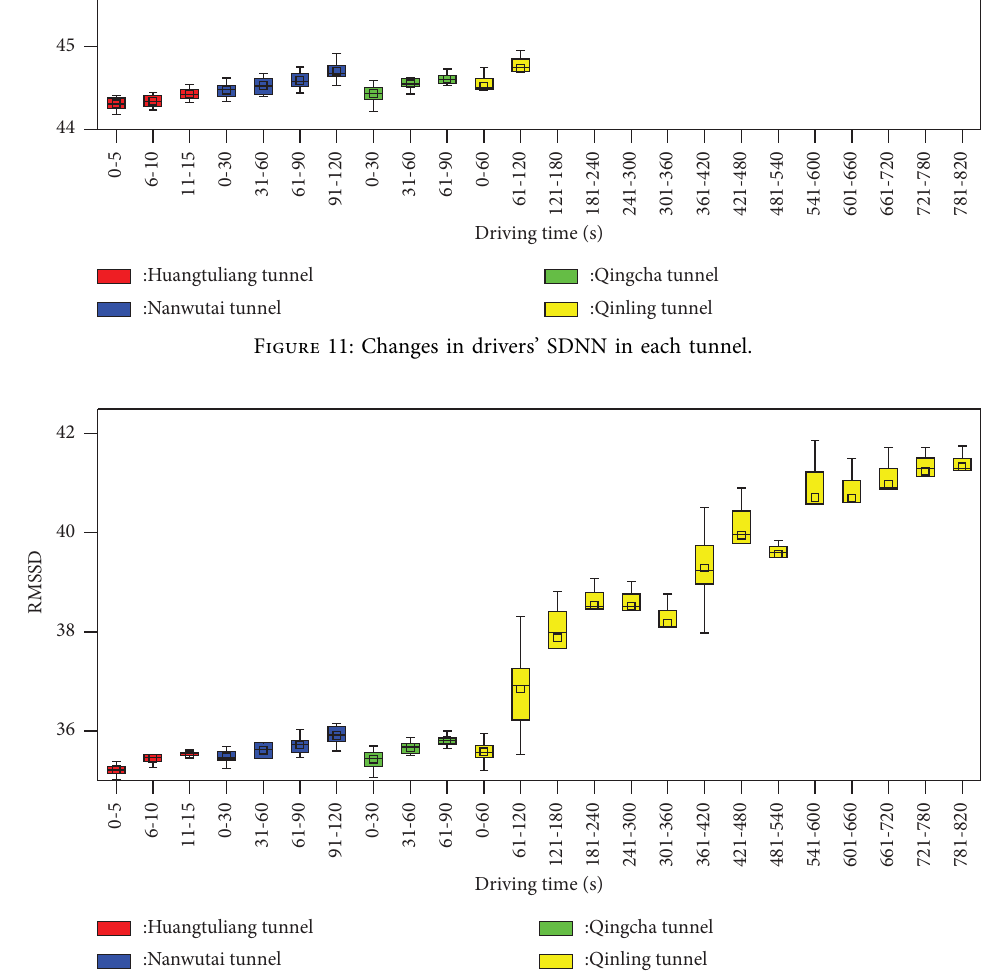
Figure 12: Changes in drivers’ RMSSD in each